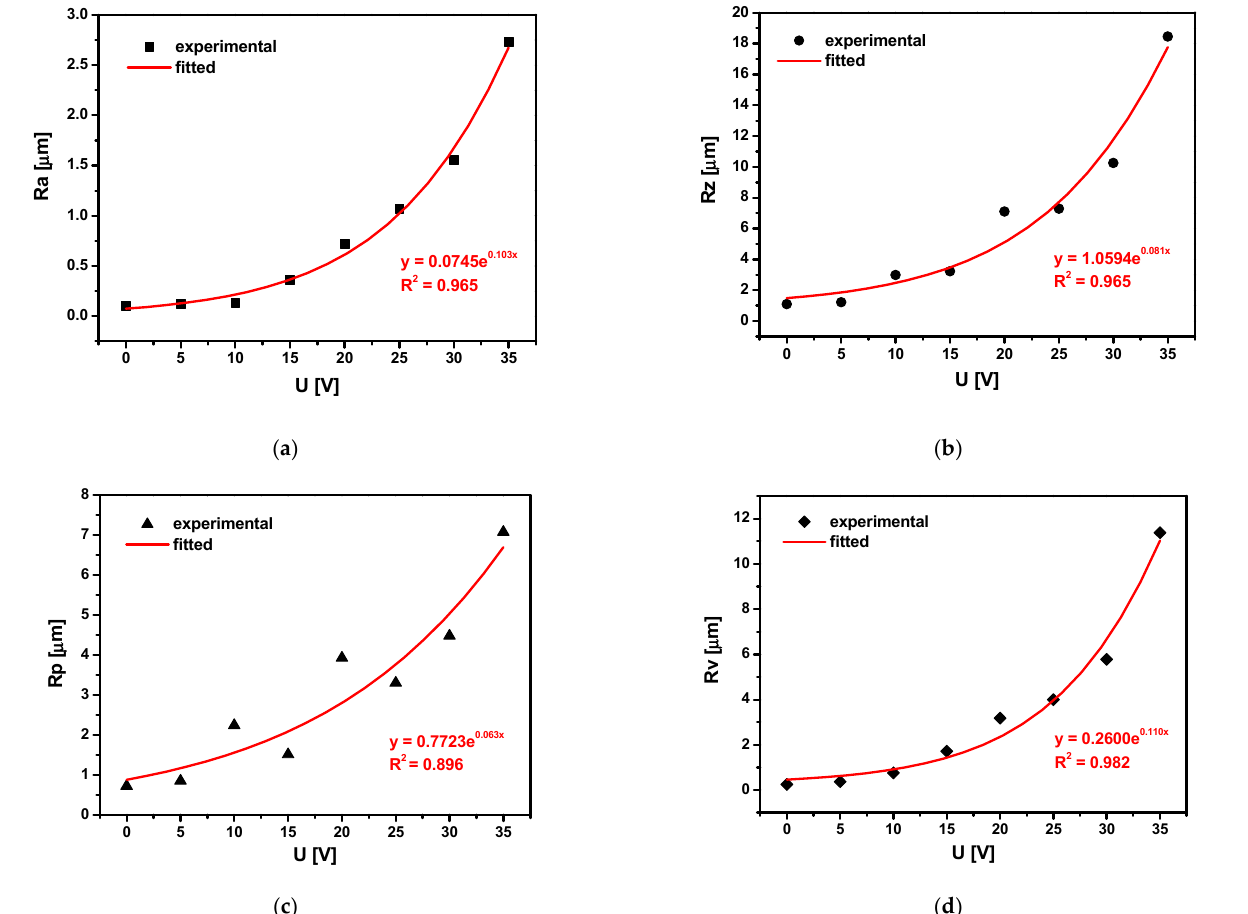
Figure 12. Basic surface texture parameters for the Ti-13Zr-13Nb alloy surface before and after anodizing: ( a ) Ra; ( b ) Rz; ( c ) Rp; ( d ) Rv. The experimental data are shown as symbols (black), and the exponential fit is shown as a solid line (red). As a result of surface treatment of the Ti-13Zr-13Nb alloy by anodizing, an exponential increase in Ra (Figure 12a), Rz (Figure 12b), Rp (Figure 12c), and Rv (Figure 12d) was